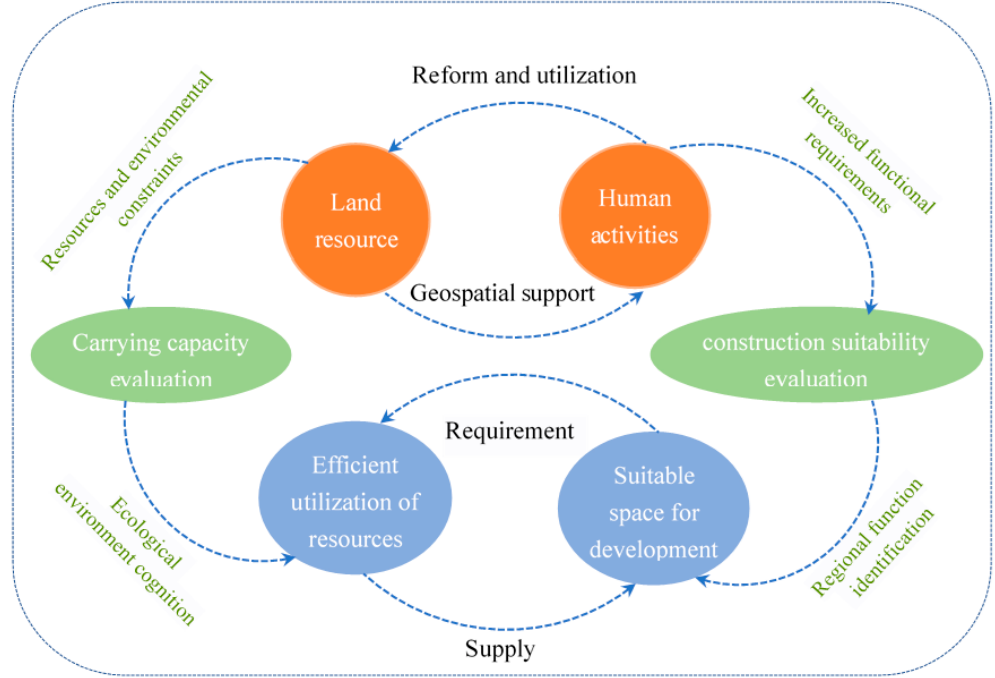
Figure 2. Theoretical logic of suitability evaluation of urban construction land (SEUCL).